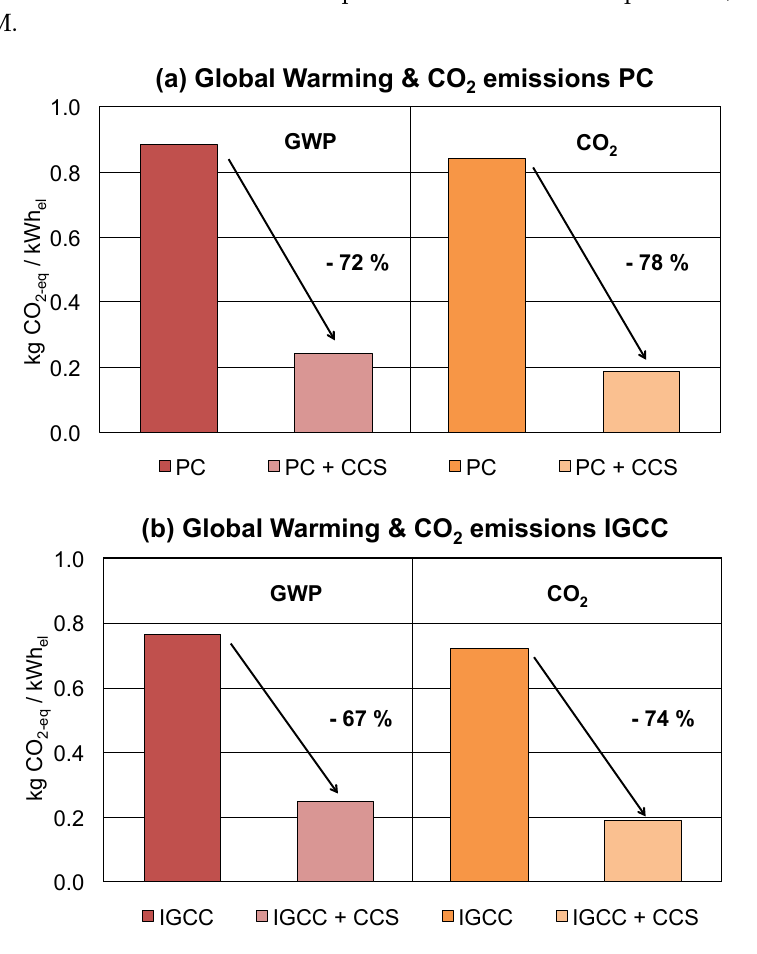
Figure 7. Specific GWP and CO 2 emissions ( a ) for supercritical PC and ( b ) for IGCC power plants with and without CCS in South Africa in 2030 from a life cycle perspective.